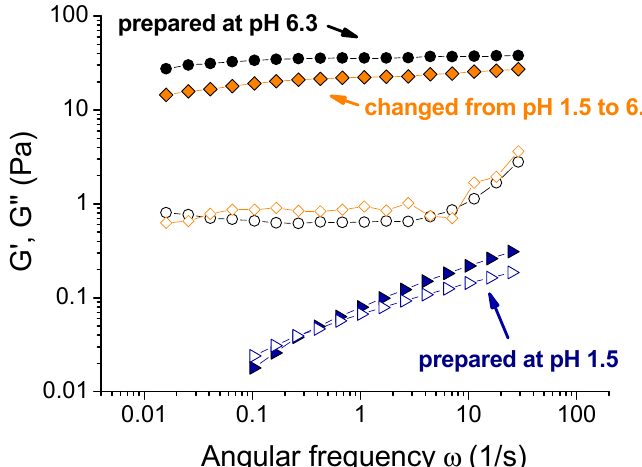
Figure 8. Frequency dependences of storage G ʹ ( fi lled symbols) and loss G” (open symbols) moduli for 0.1 wt % xanthan aqueous solutions in the presence of 0.017 wt % CrCl 3 corresponding to the molar ratio [CrCl 3 ]/[xanthan monomer units] = 1: prepared at pH 1.5 (triangles); prepared at pH 6.3 (circles); obtained by the addition of 138 µ L of 5 M KOH to the 4 mL solution initially prepared at pH 1.5